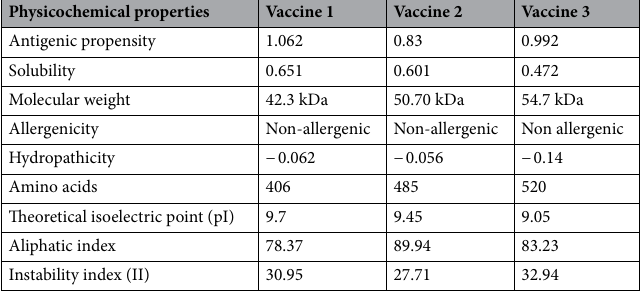
Table 8. Comparison of physicochemical and solubility properties of different vaccine